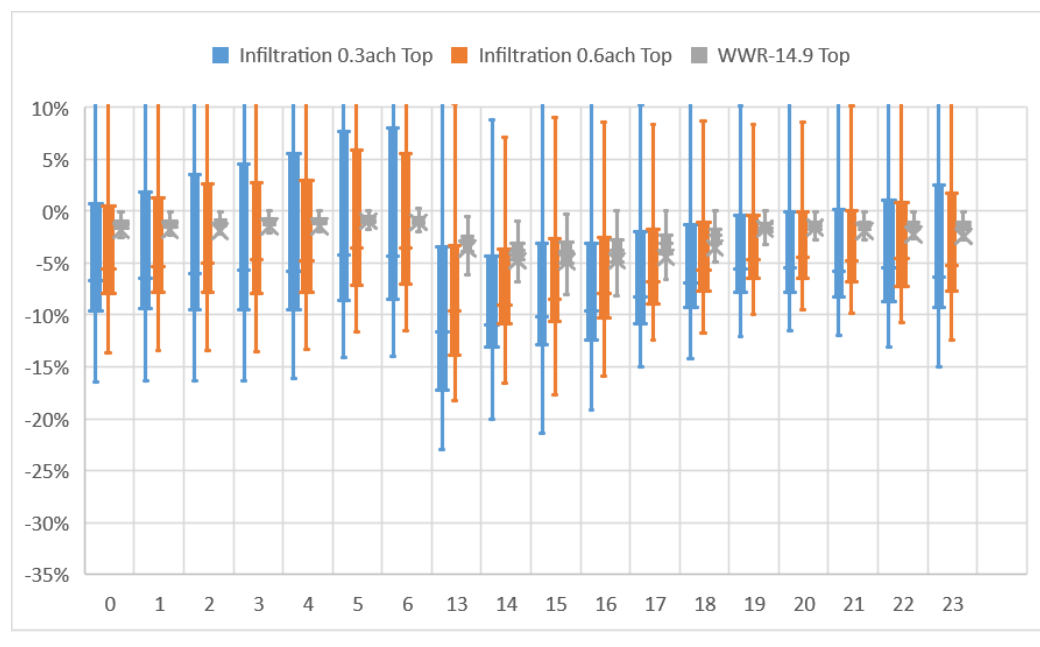
( c ) Box charts for hourly percentage difference in a year for tests for the Top Floor, (1) Building Orientation rotated 30deg clockwise; (2) Building Orientation rotated 45deg clockwise; (3) Building Orientation rotated